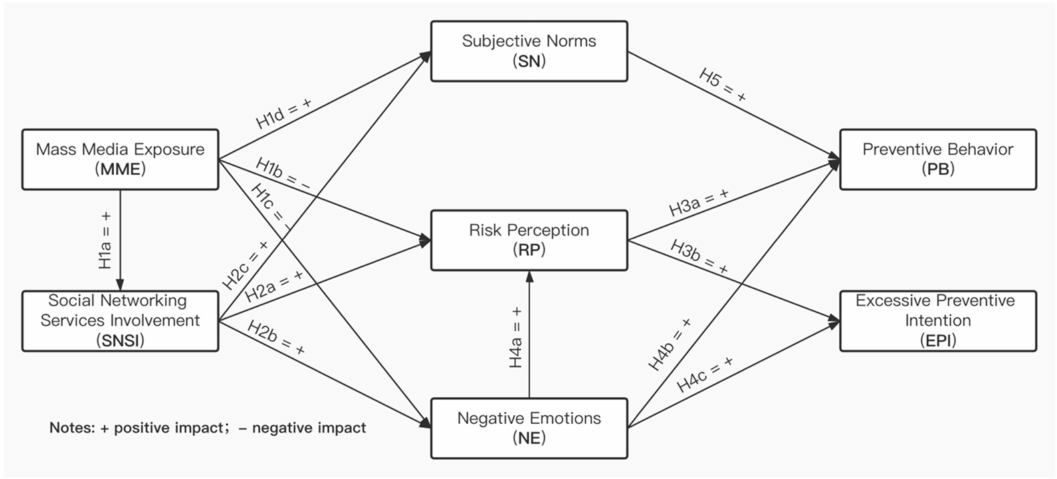
Figure 1. Research